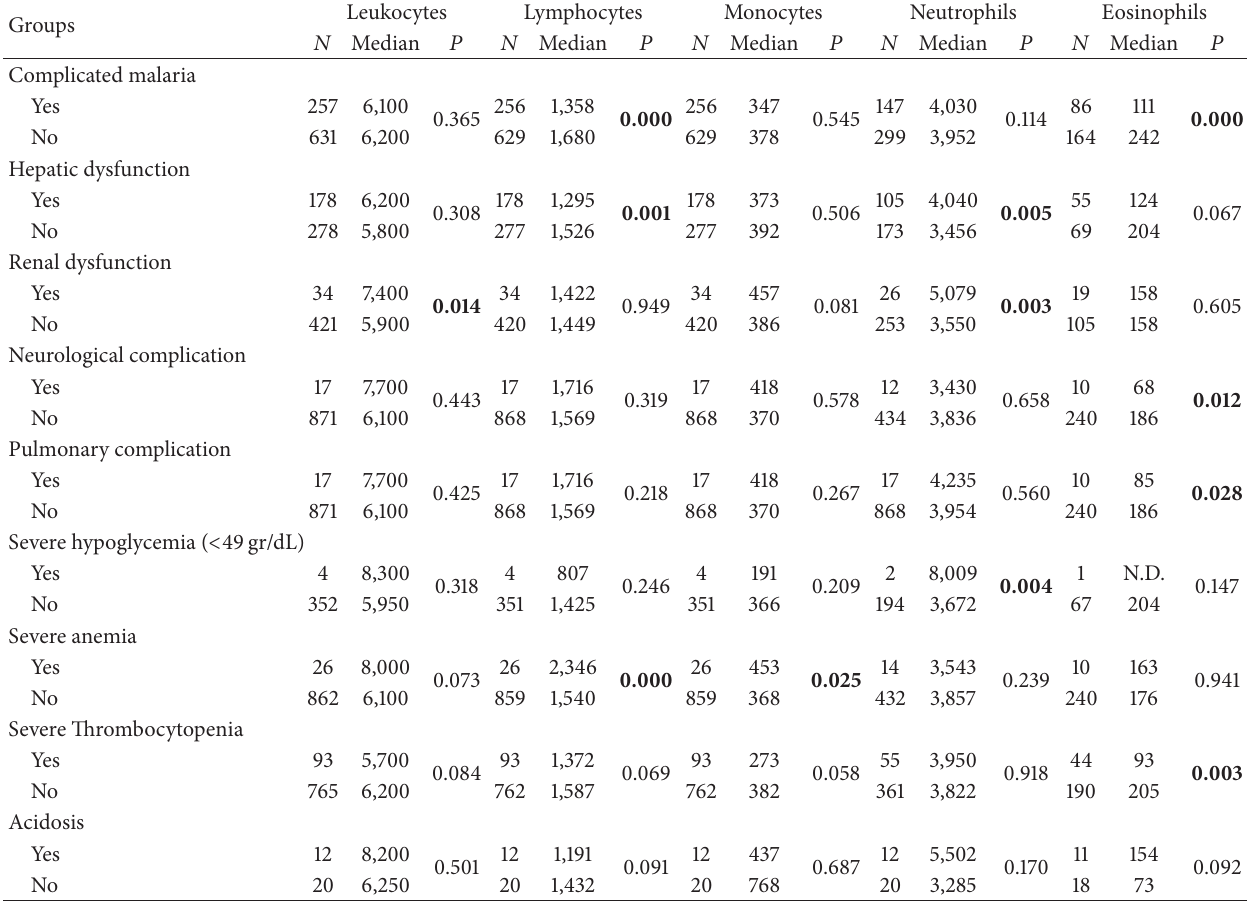
Table 6: Leucocyte counts (cells/ 𝜇 L) in relation to clinical condition ∗